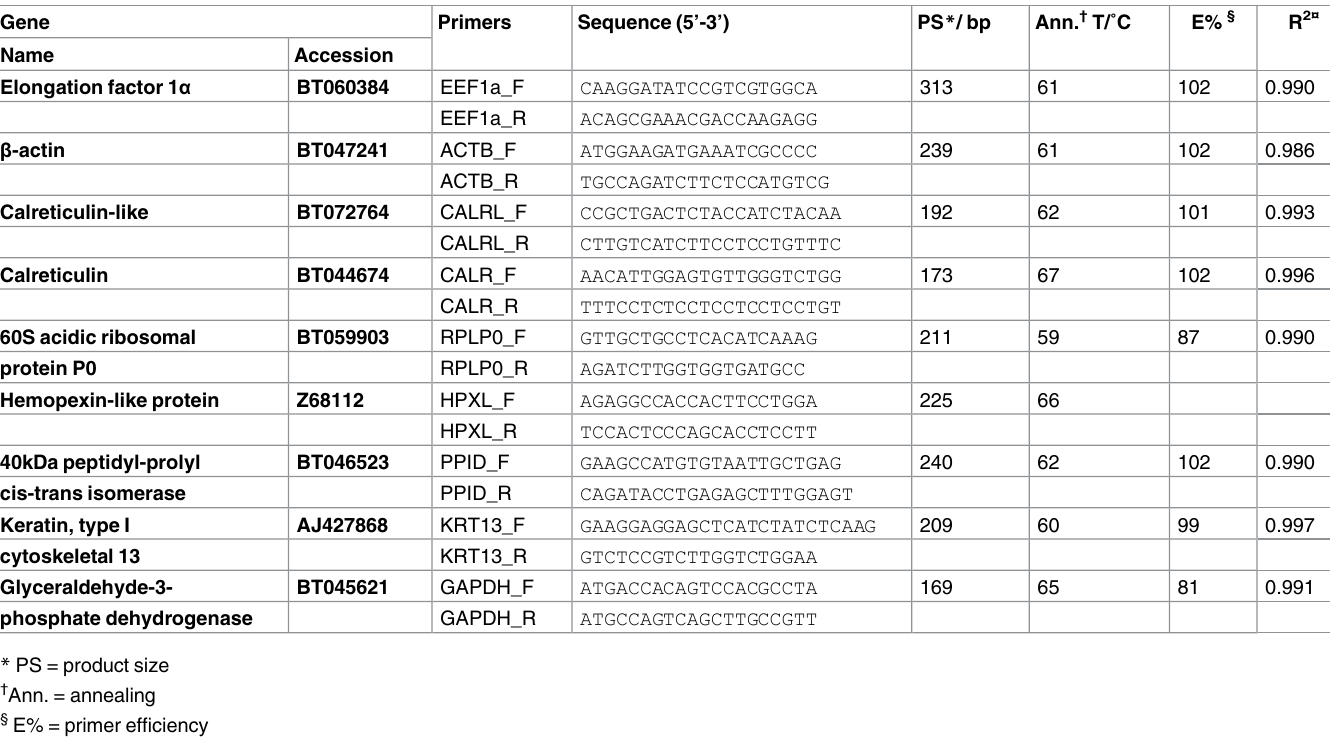
Table 2. Primer sequences, together with their optimum annealing temperature and product size, used for the gene expression studies in Atlantic salmon skin cDNA. Gene Primers Sequence